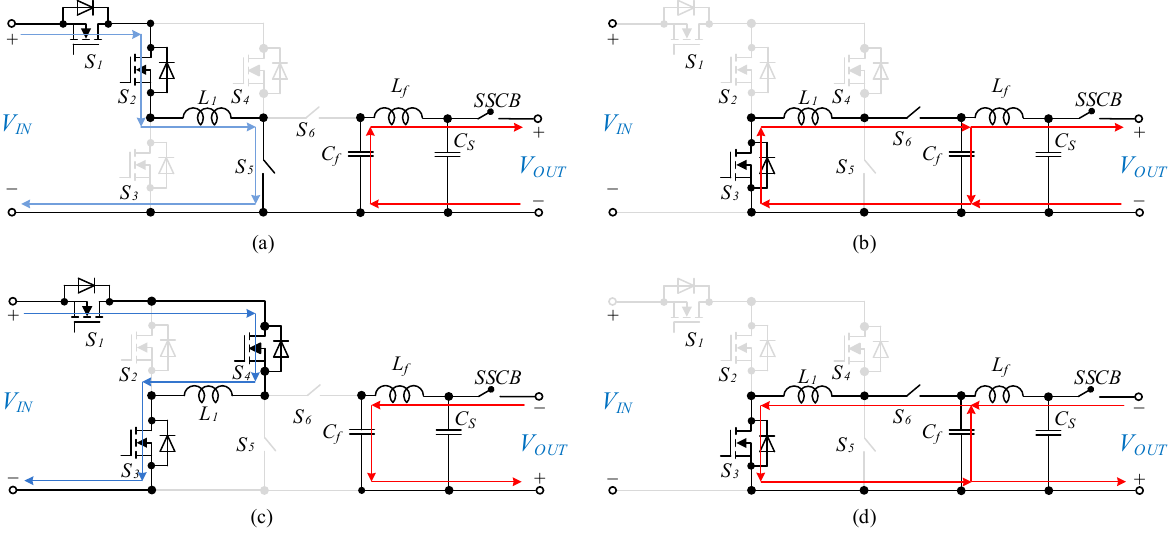
Figure 6. Equivalent circuits of the selected topology in the buck–boost (symmetrical) mode: ( a ) first equivalent circuit during positive output voltage generation, ( b ) second equivalent circuit during positive output voltage generation, ( c ) first equivalent circuit during negative output voltage generation, and ( d ) second equivalent circuit during negative output voltage generation.